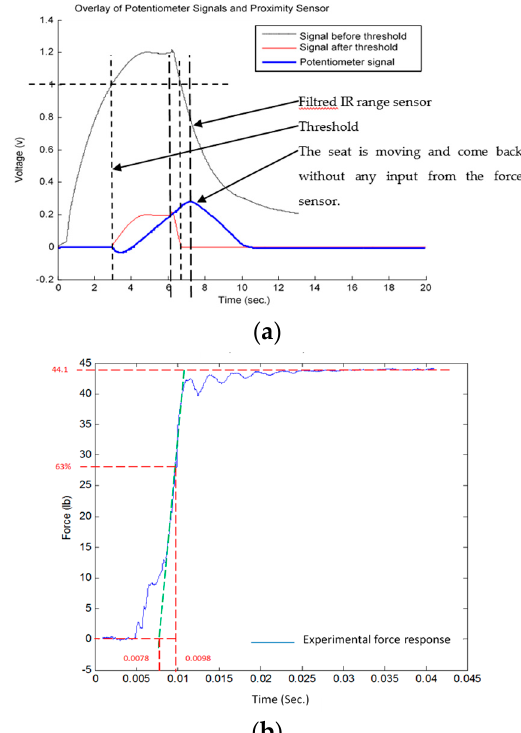
Figure 12. ( a ) Superposition of the two responses of the potentiometer and the proximity sensor ( b ) response of the force sensor submitted to the admittance model.